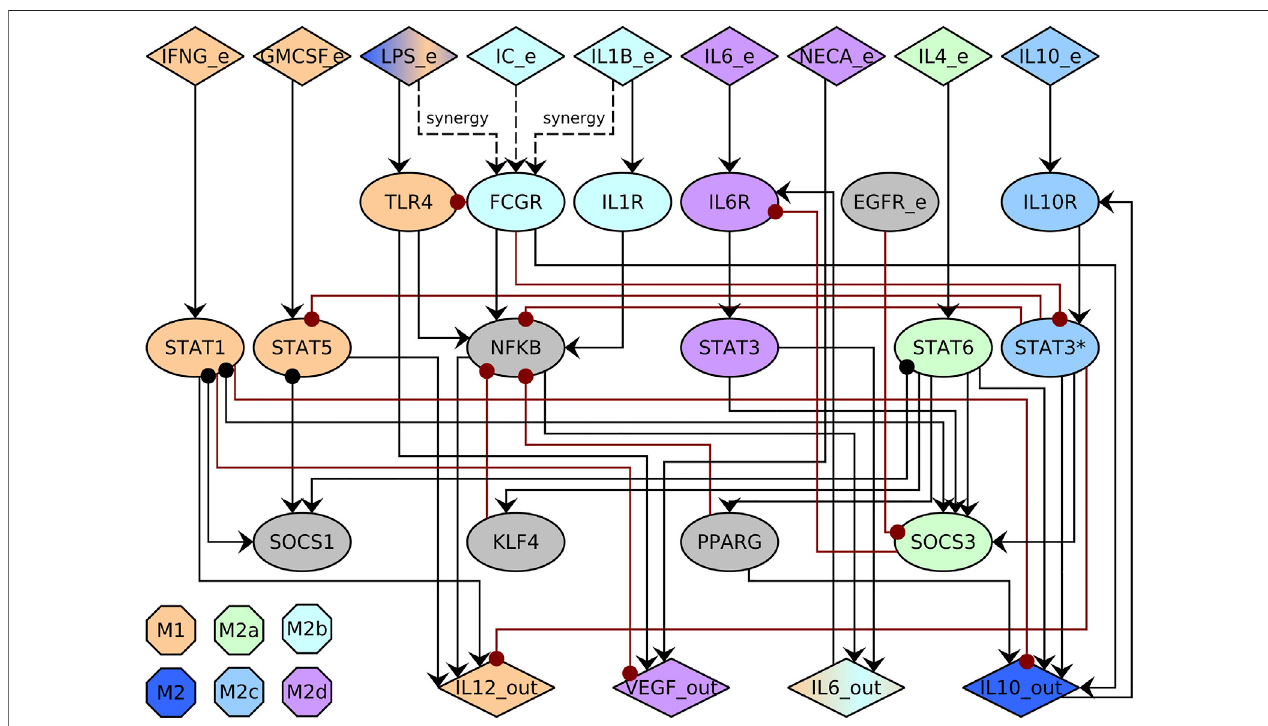
FIGURE2| Macrophageregulatorynetwork.Thenetworkincludescytokinesintheenvironment(_e)andproducedbythemacrophage(_out),signalingpathways, andtranscriptionfactors(ellipses).Activationsarerepresentedwithblackarrows,andinhibitionswithreddottedarrows.WeuseSTAT3forIL-6dependentsignalingand STAT3* for IL-10 dependent signaling. The color of the node corresponds to the associated cell